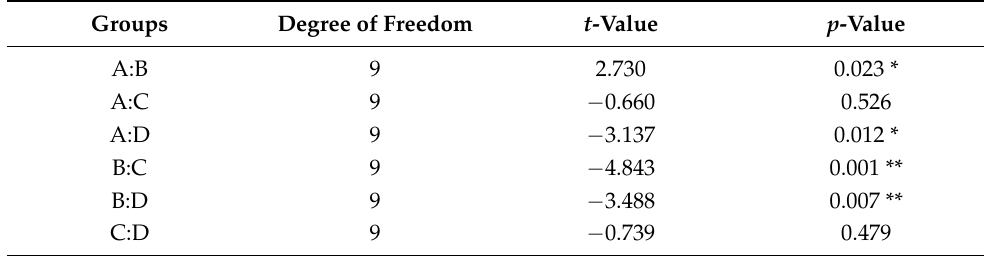
Table 9. t -Test results of differences in rate of